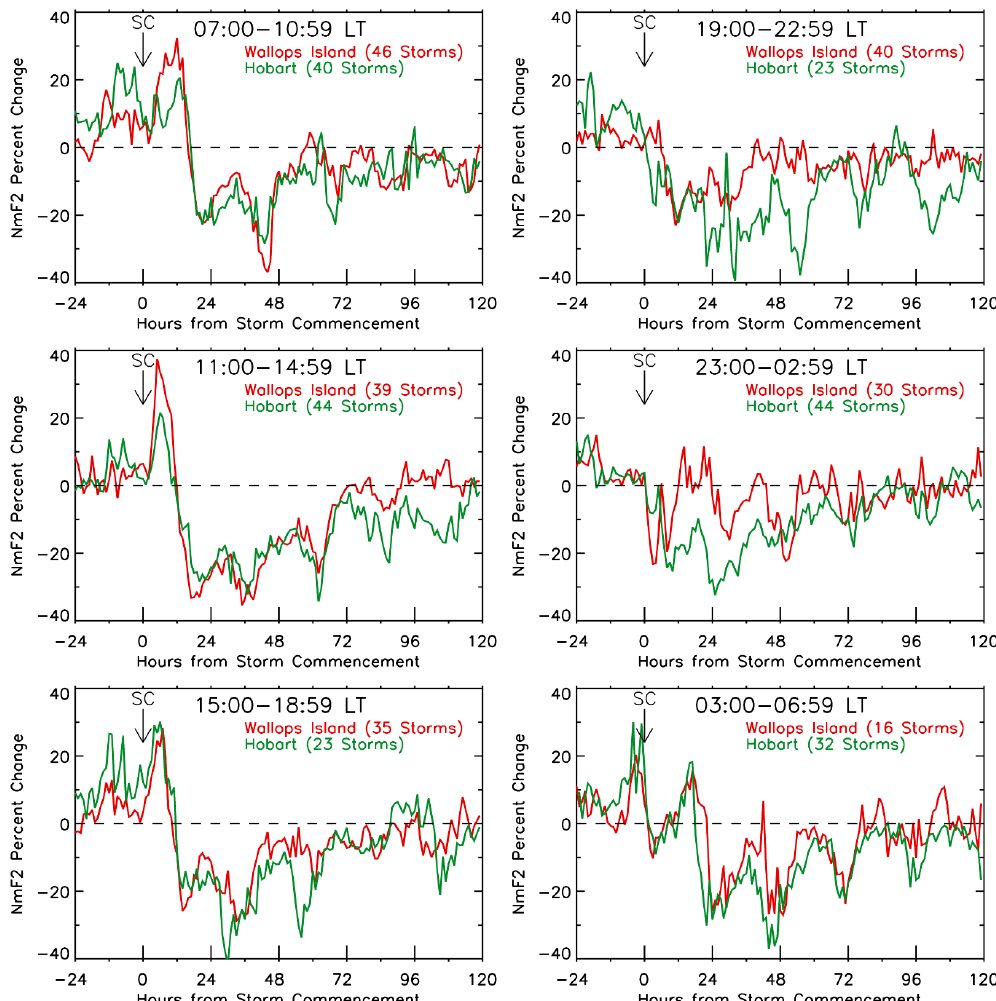
Fig. 7. Average storm-time patterns for Wallops Island and Hobart sorted by the local time (LT) of the storm commencement. The panels on the left give daytime SCs in 4-h windows; panels on the right give nighttime SC